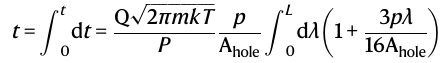
Fig. 4 | Hole pattern with a depth of 1600 nm, an opening diameter of 100nm and a bottom diameter of 50nm used for gap- fi lling. a TEM images of the subsequent 40nm thick TiO 2 ALD fi lm on the 0, 40 and 60s TMPMCT inhibitors and 40s TMPMCT with an additional H 2 O/10nm TiO 2 /SiO 2 hole. b Growth and